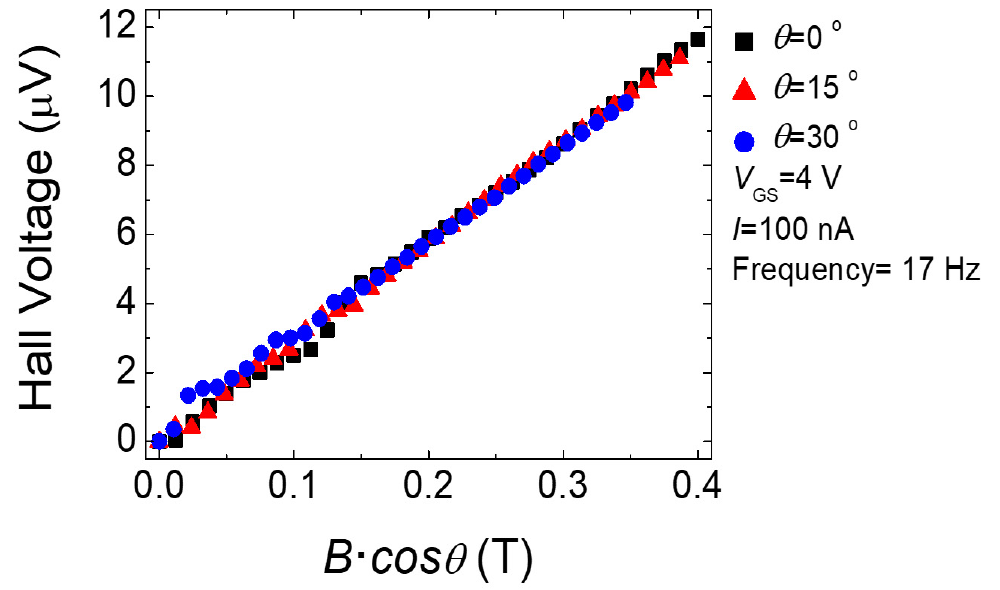
Figure 5. Offset-corrected Hall voltages at a gate voltage V GS of 4 V and current level I of 100 nA as a function of the perpendicular magnetic field at tilting angles of 0°, 15°, and 30°.